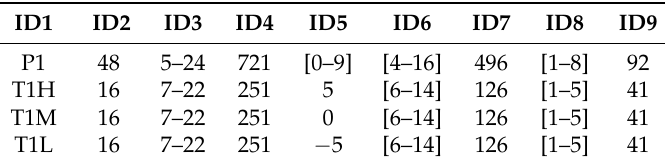
Table 1. Characteristics of each